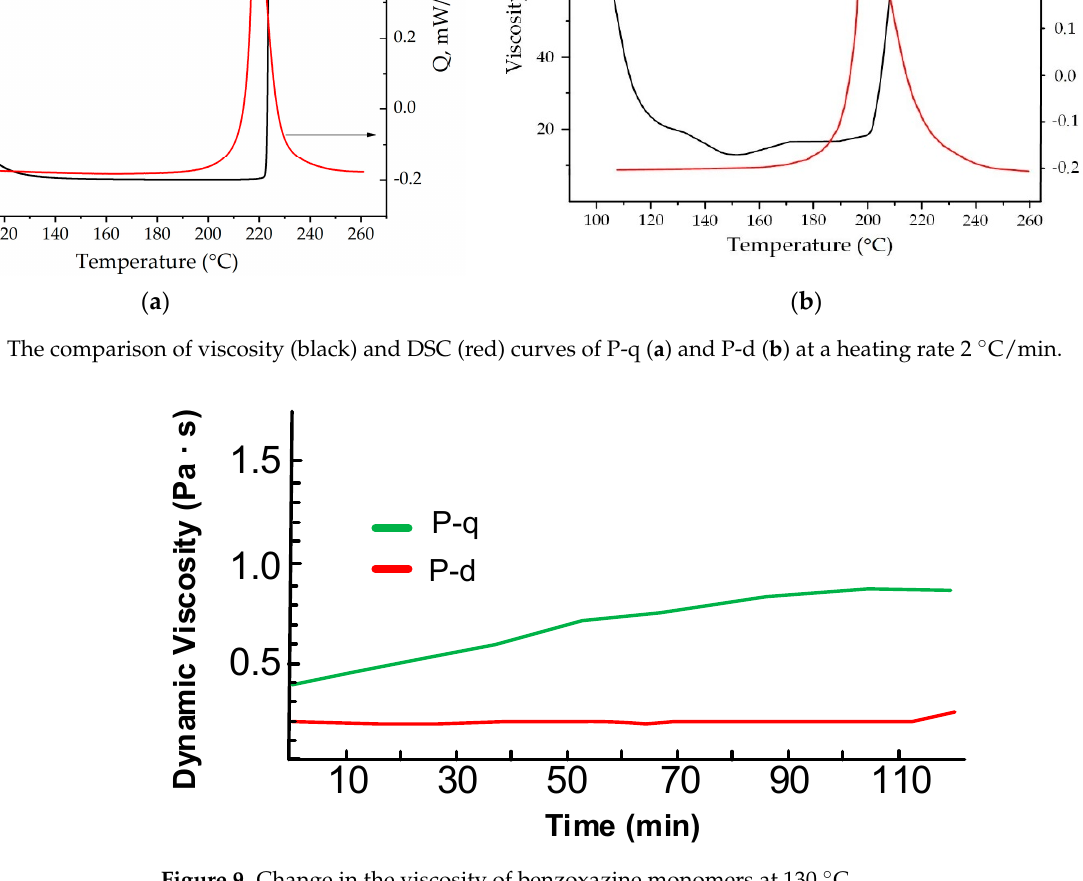
Figure 9. Change in the viscosity of benzoxazine monomers at 130 °C.